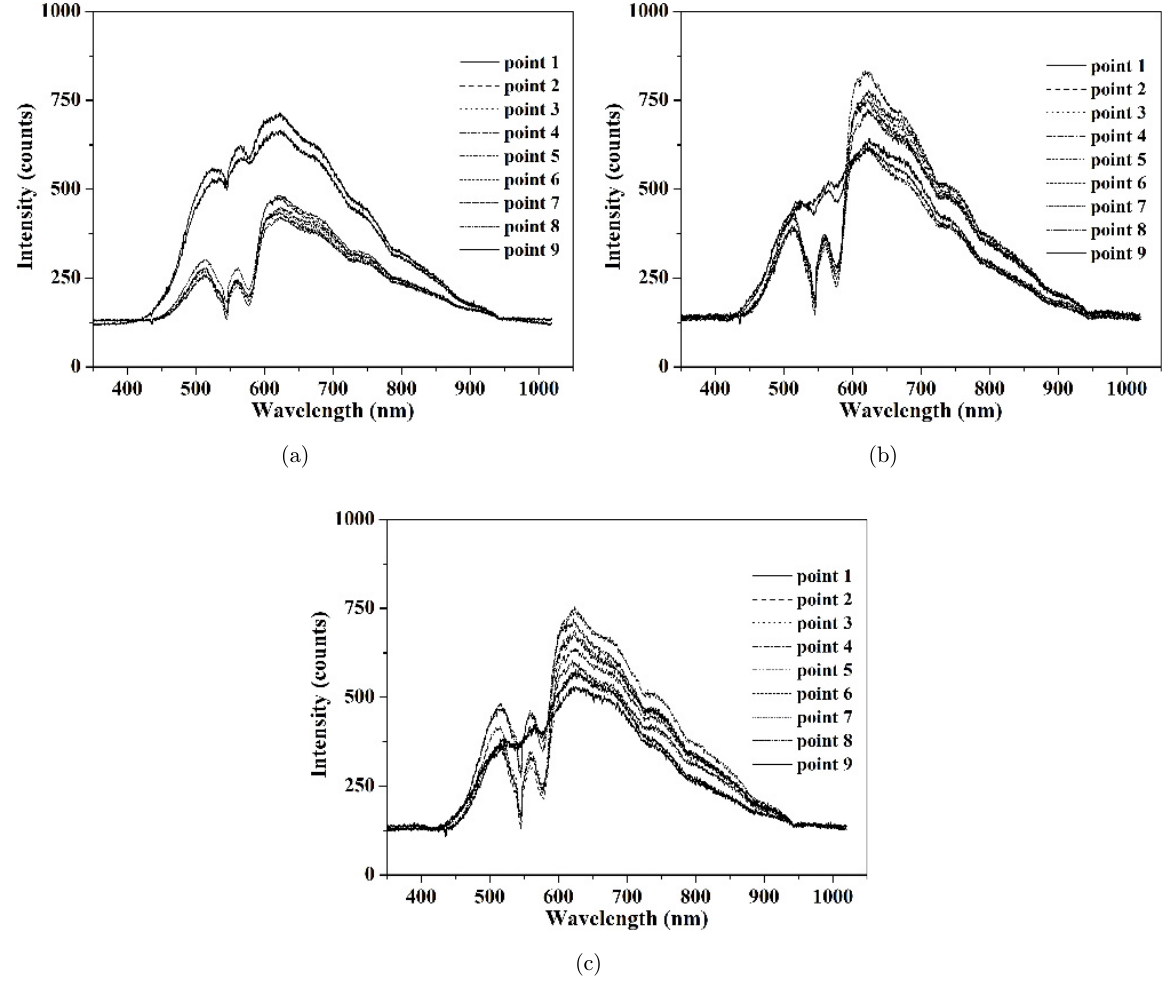
Fig. 2. Original spectra of di®erent animal vertebra (a) porcine vertebra, (b) bovine vertebra, (c) ovine